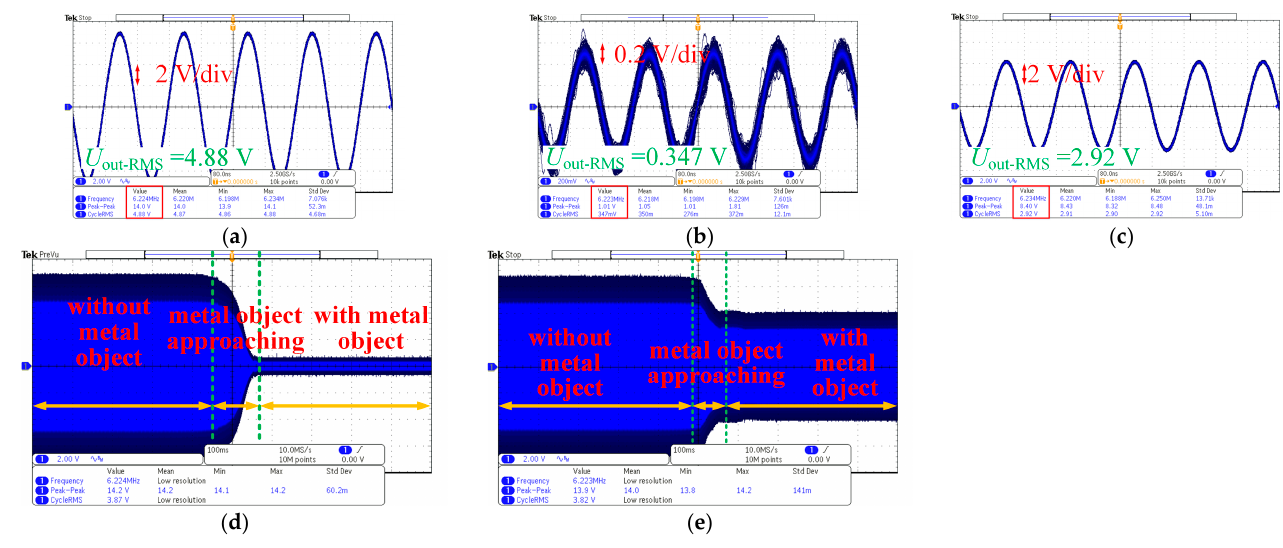
Figure 18. Output waveform of detection circuit U out with excitation frequency f = 6.22 MHz when foreign object was 1 RMB yuan coin. ( a ) Normal condition without foreign metal object. ( b ) Coin in the center position of the detection coil. ( c ) Coin in the corner position of the detection coil. ( d ) The moment of the U out amplitude variation caused by 1 RMB yuan coin entering the center position of the detection coil. ( e ) The moment of the U out amplitude variation caused by 1 RMB yuan coin entering the corner position of the detection coil.